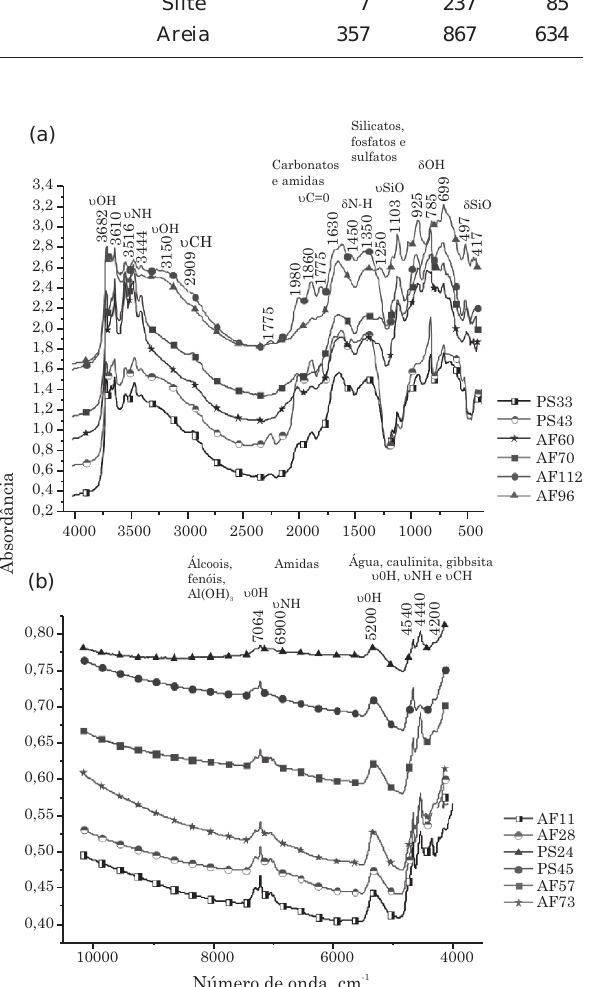
Figura 2. Exemplos de espectros de absorbância em infravermelho médio - DRIFTS (a) e infravermelho próximo - NIRS (b) de solos do CNPAF (representados por AF) e do CPPSE (representados por